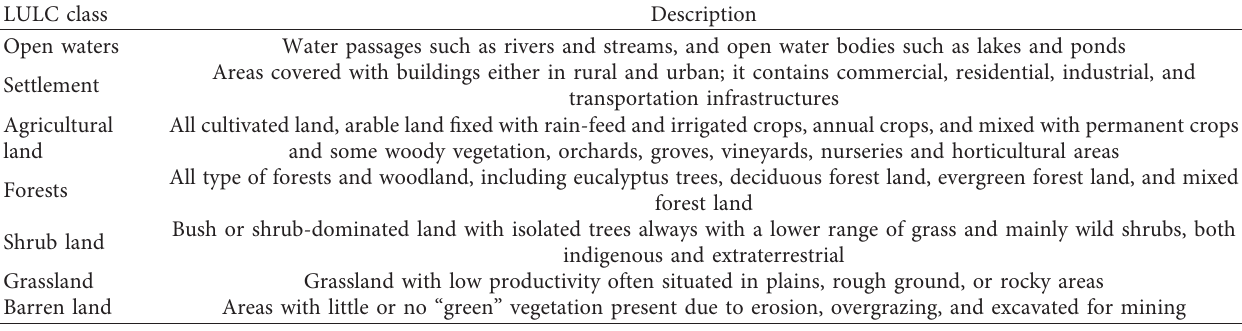
Table 6: Details of land use land cover.